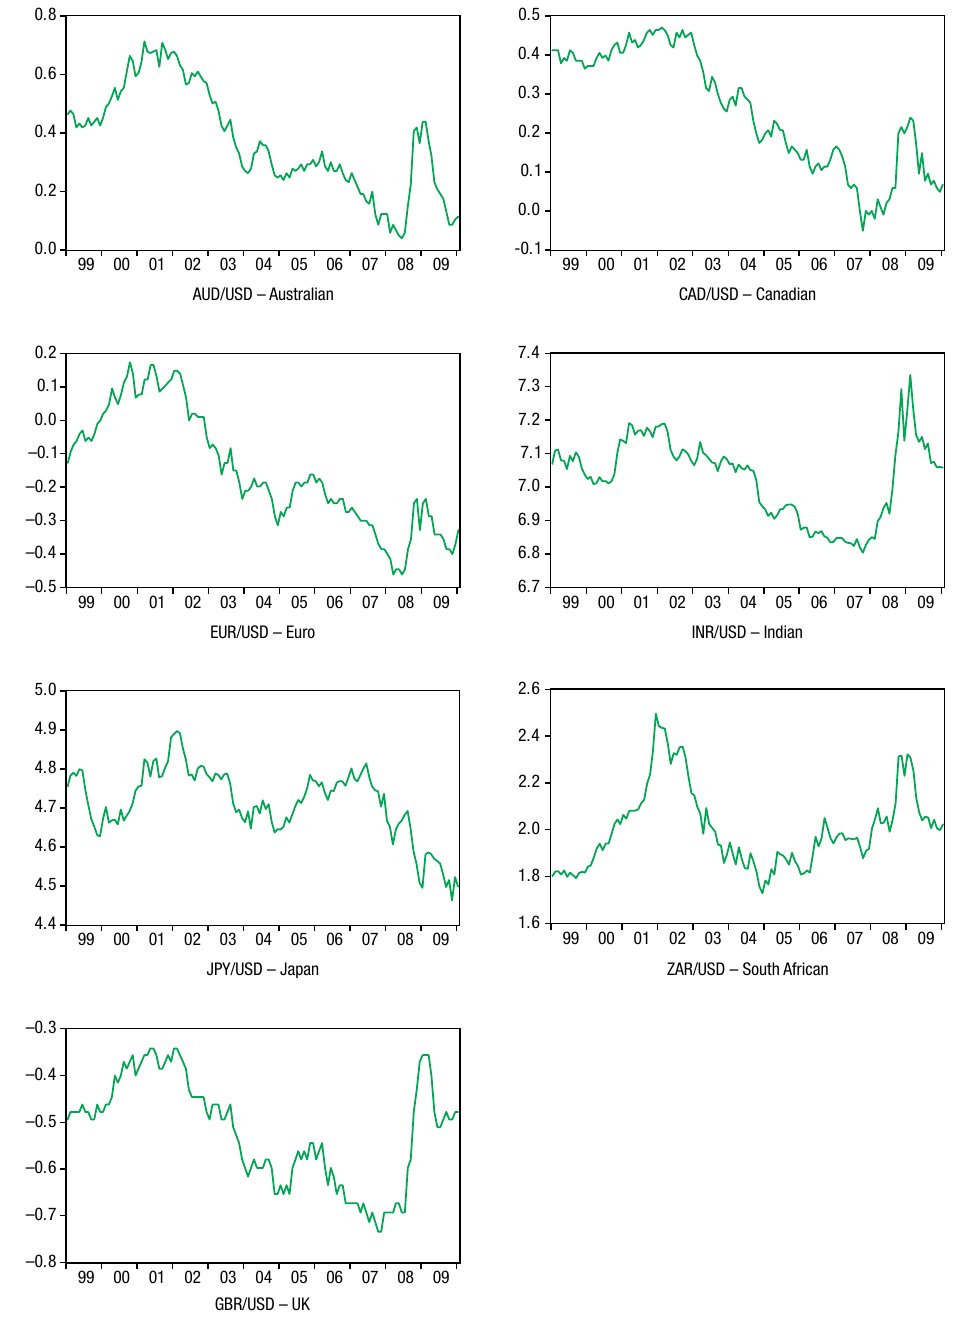
Fig. 4. The trends of the exchange